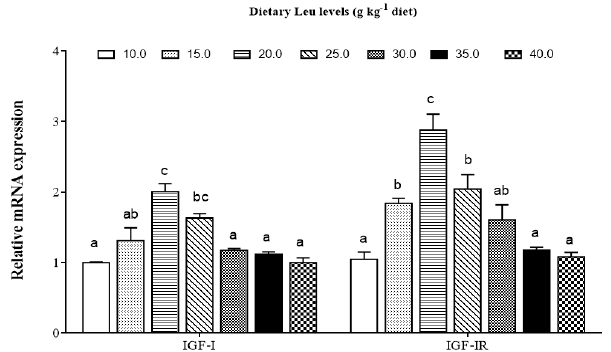
Figure 4. Effects of dietary Leu on IGF ‐ I and IGF ‐ IR gene expressions in muscle of hybrid catfish. Values are means ± SEM of three replicates, with six fish in each replicate, and different letters denote significant differences ( P < 0.05).